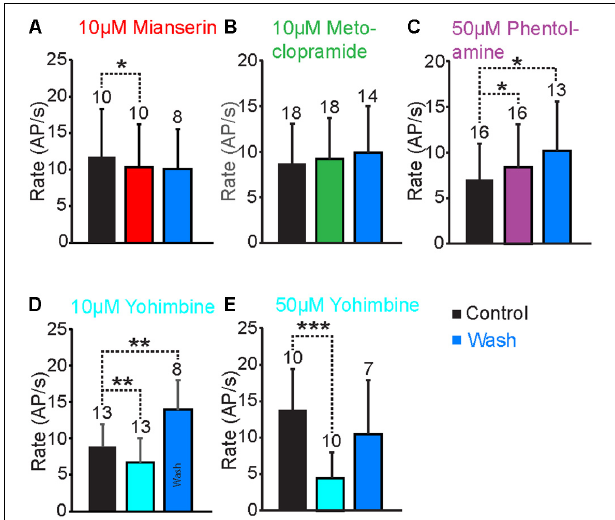
FIGURE 6 | Antagonist effects on the baseline AP rate. (A) When the VS-3 neurons were superfused in saline with 10 µ M mianserin the AP rate decreased slightly but significantly (paired t -test: t = 2.36, df = 9, p = 0.0213005). The AP rate after wash was not statistically significantly different when compared to control ( t = 10.94, df = 7, p = 0.189257). (B) When metoclopramide was added to superfusion, the AP rate did not change (paired t -test t = –0.74, df = 17, p = 0.234699) and it remained unchanged after a wash (paired t -test t = –1.51, df = 13, p = 0.077481). (C) Superfusion in saline with phentolamine made the neurons fire slightly more (paired t -test t = –1.76, df = 15, p = 0.04939) and the AP rate increased further after wash (paired t -test t = –2.25, df = 12, p = 0.021999). (D) Ten micromolar yohimbine reduced the baseline spiking significantly (Wilcoxon ranked-sum test W = 71, n s / r = 13, z = 2.46, p = 0.0069). After wash the baseline firing rate was significantly higher than under control conditions (Wilcoxon ranked-sum test W = –36, n s / r = 8, p = 0.005). (E) Fifty micromolar yohimbine also reduced the AP rate significantly (paired t -test t = 4.45, df = 18, p = 0.000155). After wash the AP rate was not statistically different when compared to the control (paired t -test t = 0.88, df = 12, p = 0.198071). Numbers of experiments are indicated above each